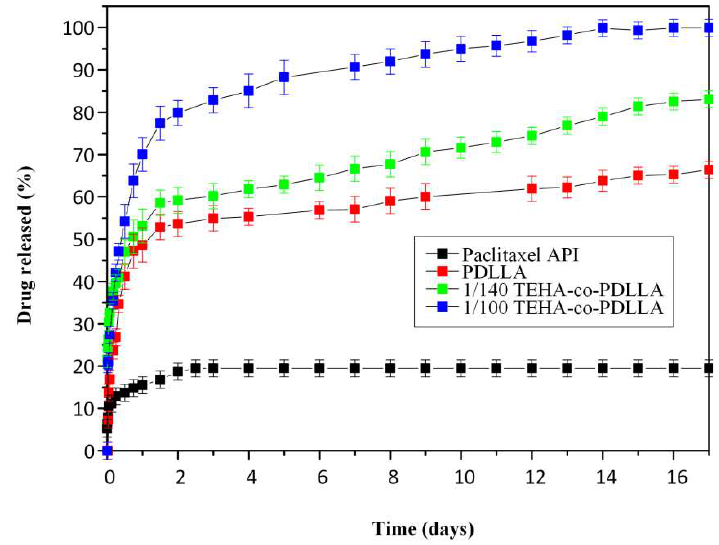
Figure 10. PXT dissolution profiles for the prepared magnetic core–shell polymeric nanoparticles.